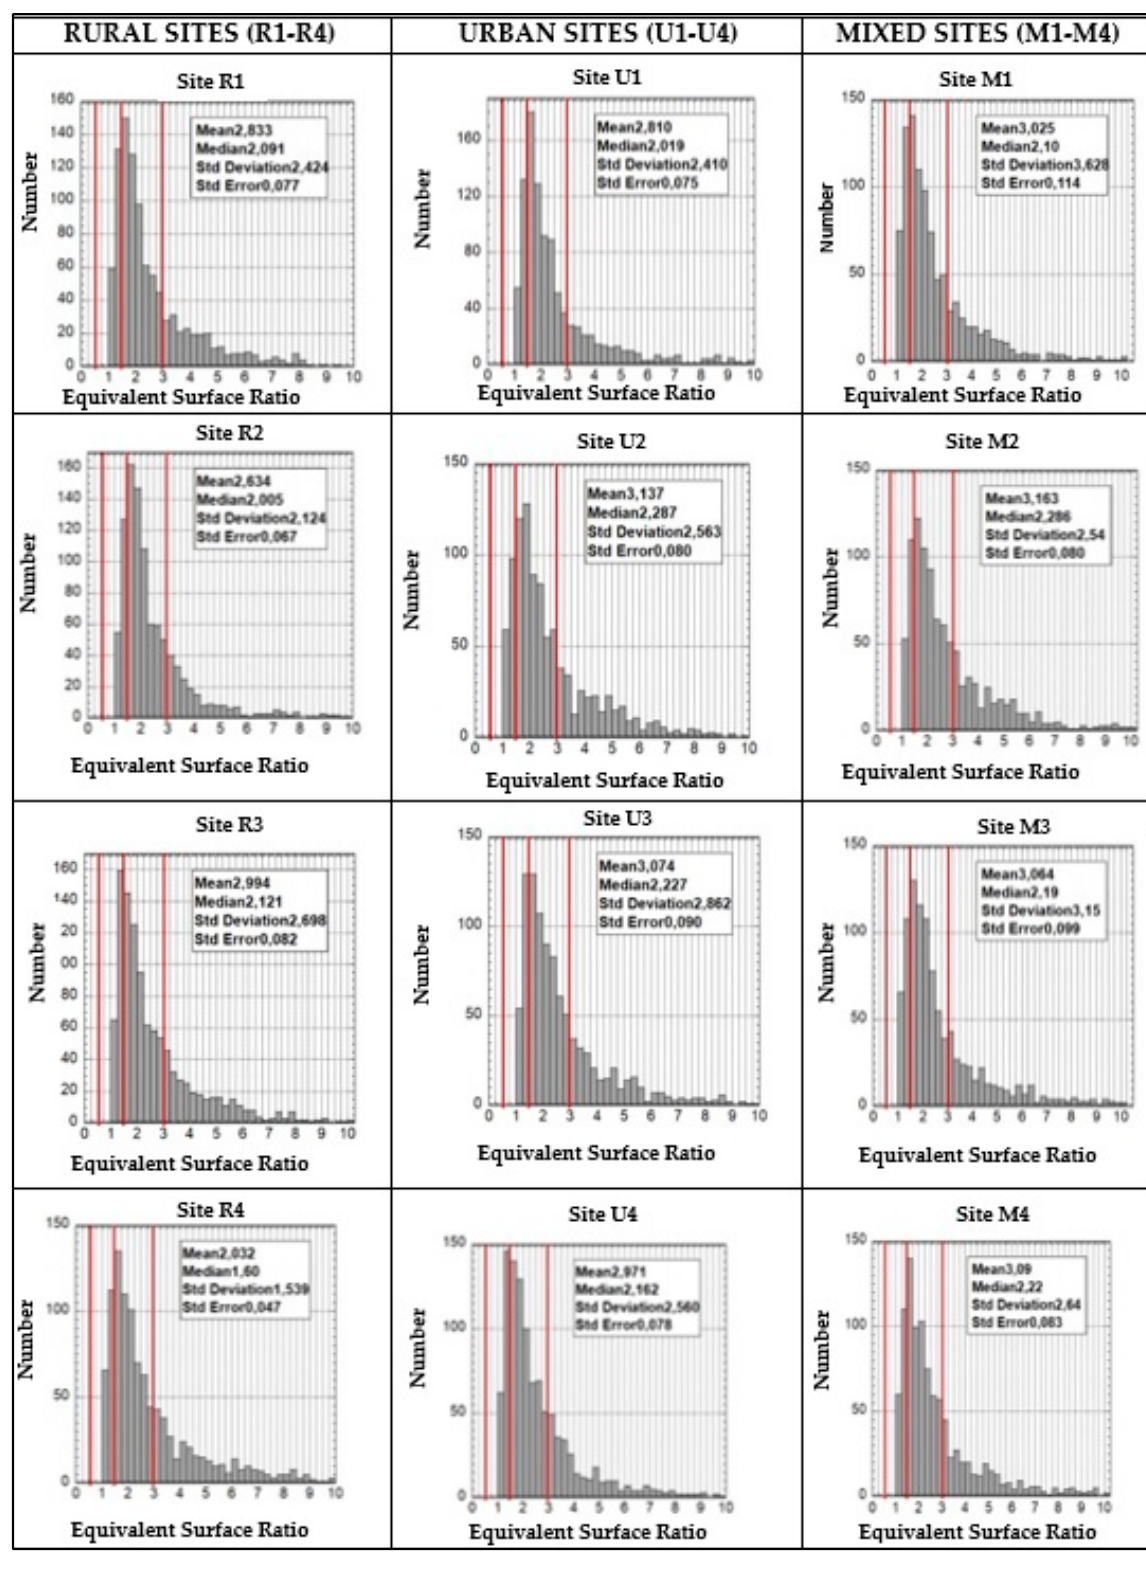
Figure 5. Site specific histograms of particles using equivalent surface ratio (ESR).